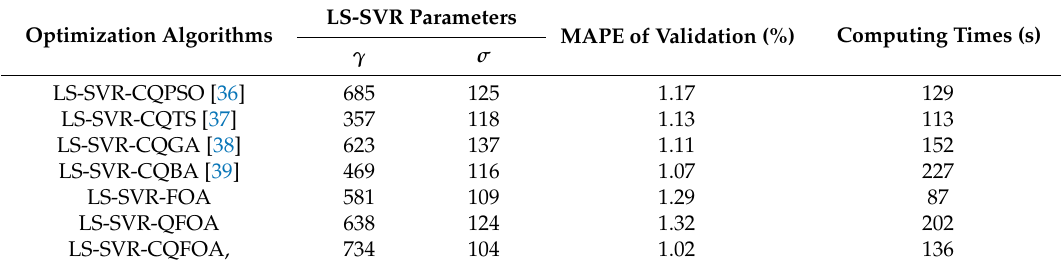
Table 4. LS-SVR parameters, MAPE, and computing times of CQFOA and other algorithms for IDAS 2014.